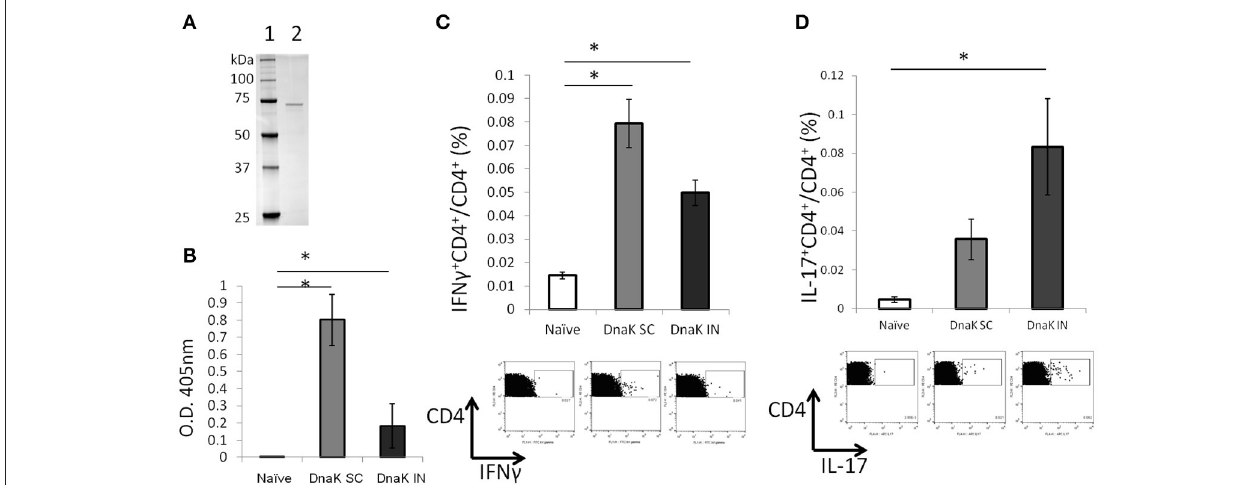
FIGURE 1 | Vaccination with DnaK protein alone generates immunoglobulin responses and antigen-specific CD4 + T cells. (A) SDS/PAGE analysis of purified DnaK protein. Lane 1: protein ladder, Lane 2: Purified His-tag Dnak protein. C57BL/6J mice were vaccinated twice with DnaK (100 µ g) by subcutaneous (SC) injection or with DnaK (20 µ g) by intranasal (IN) injection. Immunological reponses were measured 2 weeks after the last vaccination. (B) Serum IgG responses to DnaK were measured by ELISA. Mean ± SEM, N = 3–4, * p < 0.05 compared to the other two groups. (C,D) Splenocytes were stimulated with DnaK protein (10 µ g/ml) and intracellular cytokine staining was used to detect antigen-specific CD4 + T cells secreting IFN γ (B) and IL-17 (C) . Mean ± SEM, N = 3–4, * p < 0.05 compared to the other group.